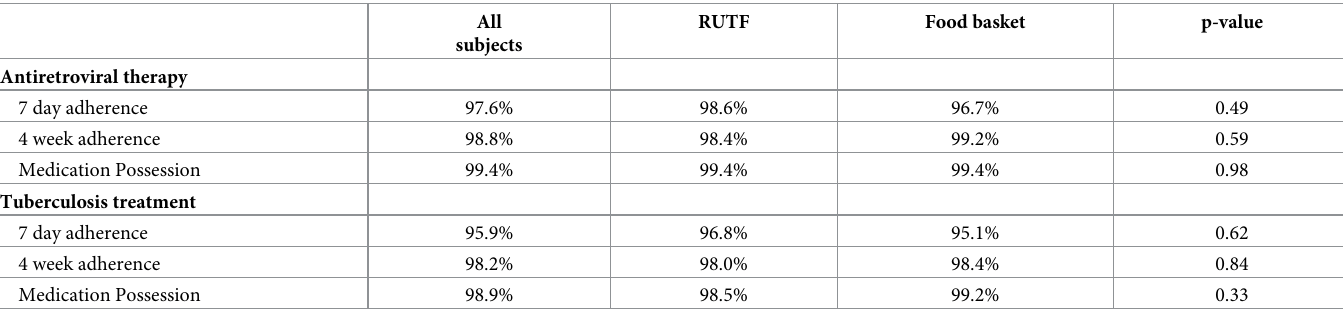
Table 4. Overall adherence to ART and TB treatment during the 6 month study period among participants who received RUTF versus the food basket. All RUTF Food basket subjects